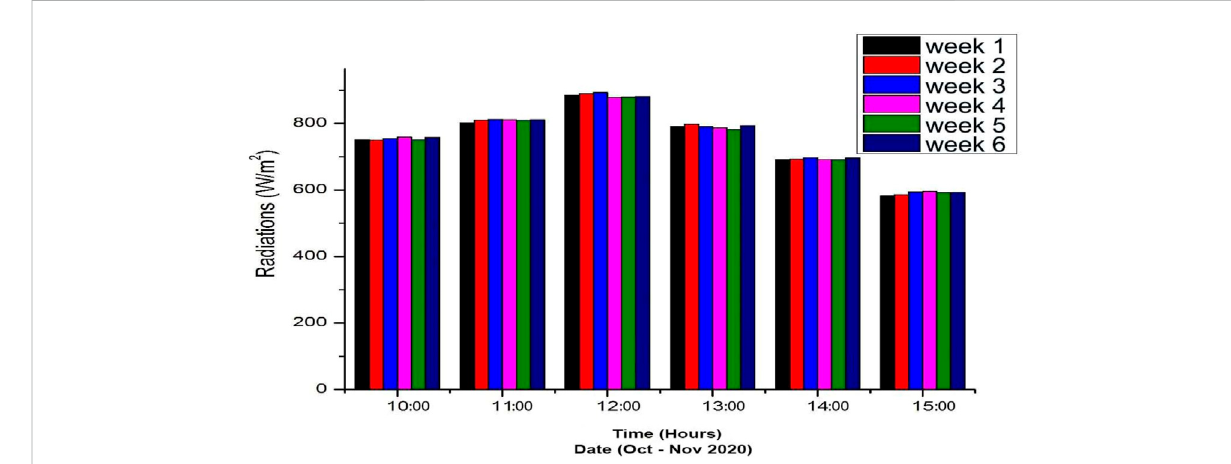
FIGURE 9 Average solar radiation data.